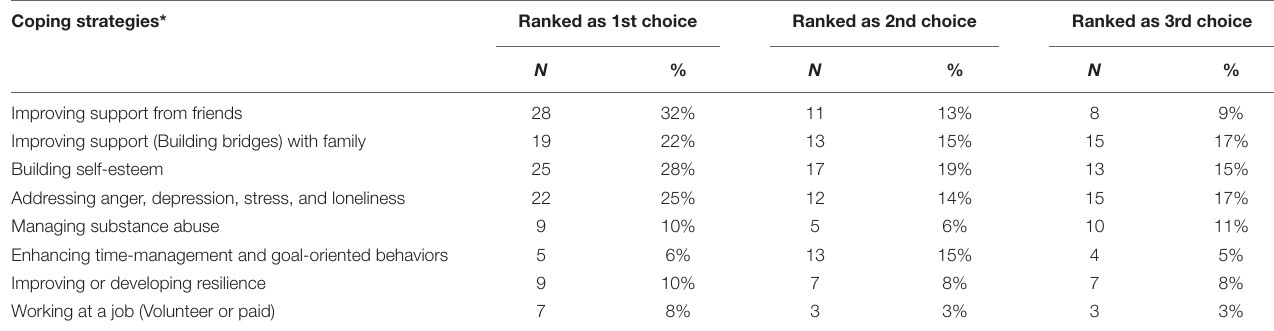
TABLE 3 | Ranking of coping strategies for suicide ideation and self-harm behaviors. Coping strategies*